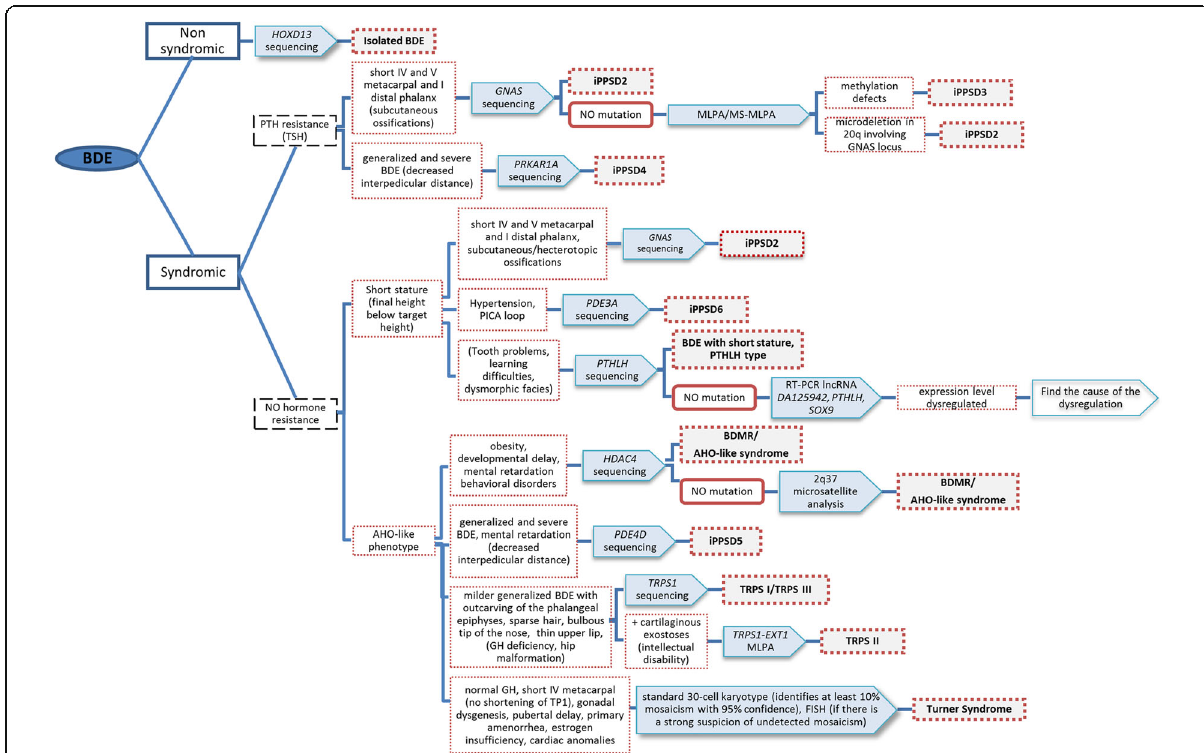
Fig. 1 Updated clinical algorithm used during this project. Features in parentheses indicate that they are not obligatory features of the syndromes. BDE: brachydactyly type E; MLPA: multiplex ligation-dependent probe amplification; MS-MLPA: methylation specific-MLPA;